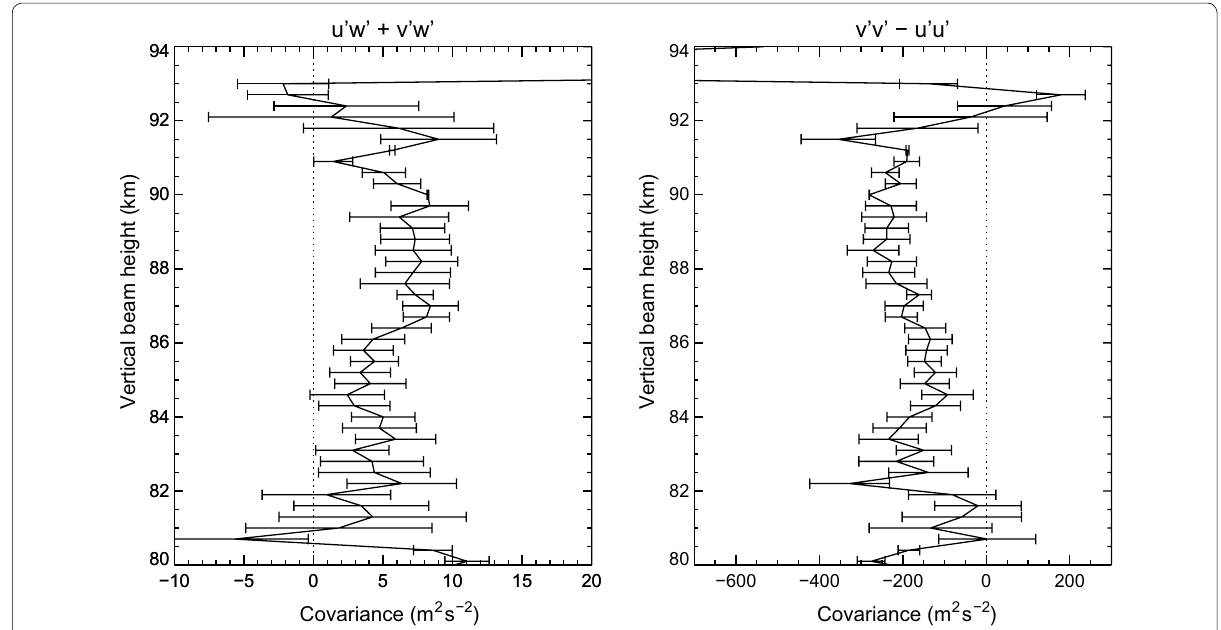
Fig. 10 Superscale momentum flux obtained using the least-squares inversion approach. Values are very similar to those shown in Fig. 9, but are somewhat less noisy